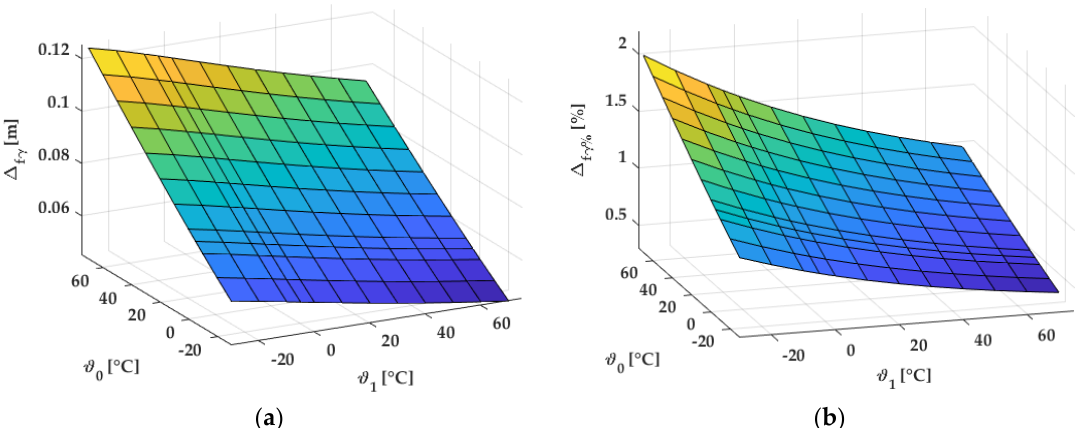
Figure 13. The dependence of sag deviations caused by the incorrect determination of the conductor specific gravity load by ±1%: ( a ) Absolute sag deviations; ( b ) percentage sag deviations.